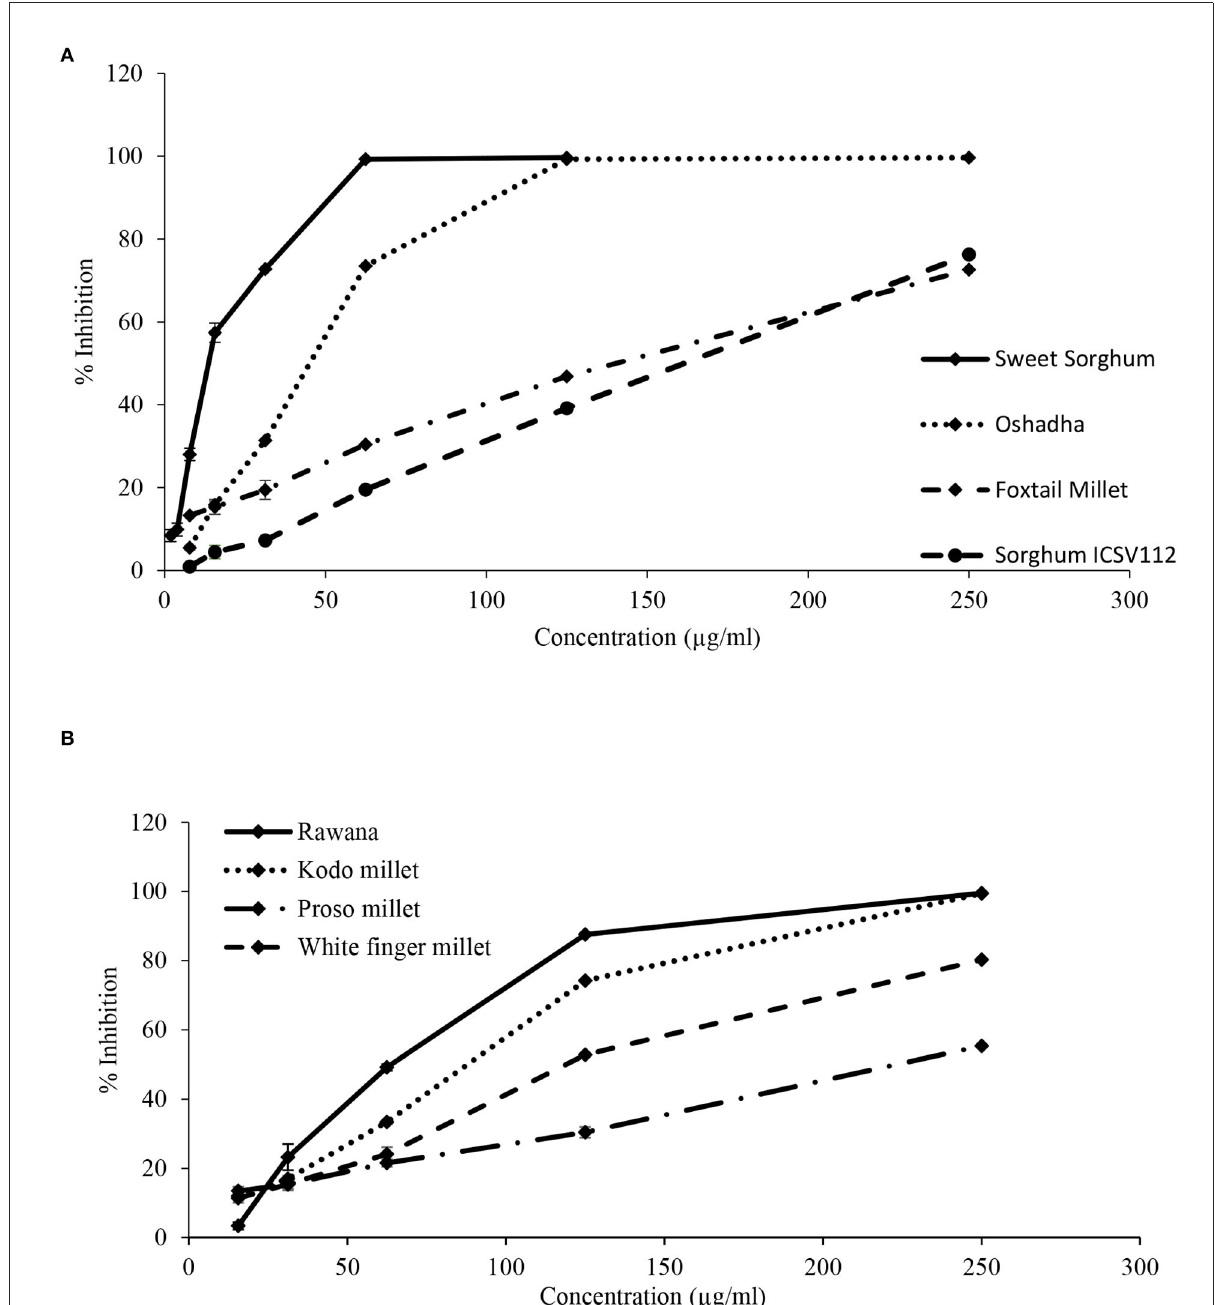
FIGURE11 Dose-response relationship of selected samples for ABTS radical scavenging activity. (A) Dose-response relationship of sorghum ICSV112, foxtail millet, Oshadha, and sweet sorghum: IC 50 values: 163.24 ± 1.11 b , 136.53 ± 6.93 c , 44.33 ± 0.19 f and 13.75 ± 0.17 g µ g/ml, respectively. (B) Dose-response relationship of proso millet, white finger millet, Kodo millet, and Rawana: IC 50 : 222.22 ± 9.46 a , 147.41 ± 0.39 c , 86.07 ± 1.64 d and 61.87 ± 0.66 e µ g/ml, respectively. IC 50 values superscripted by different letters are significantly different at p <